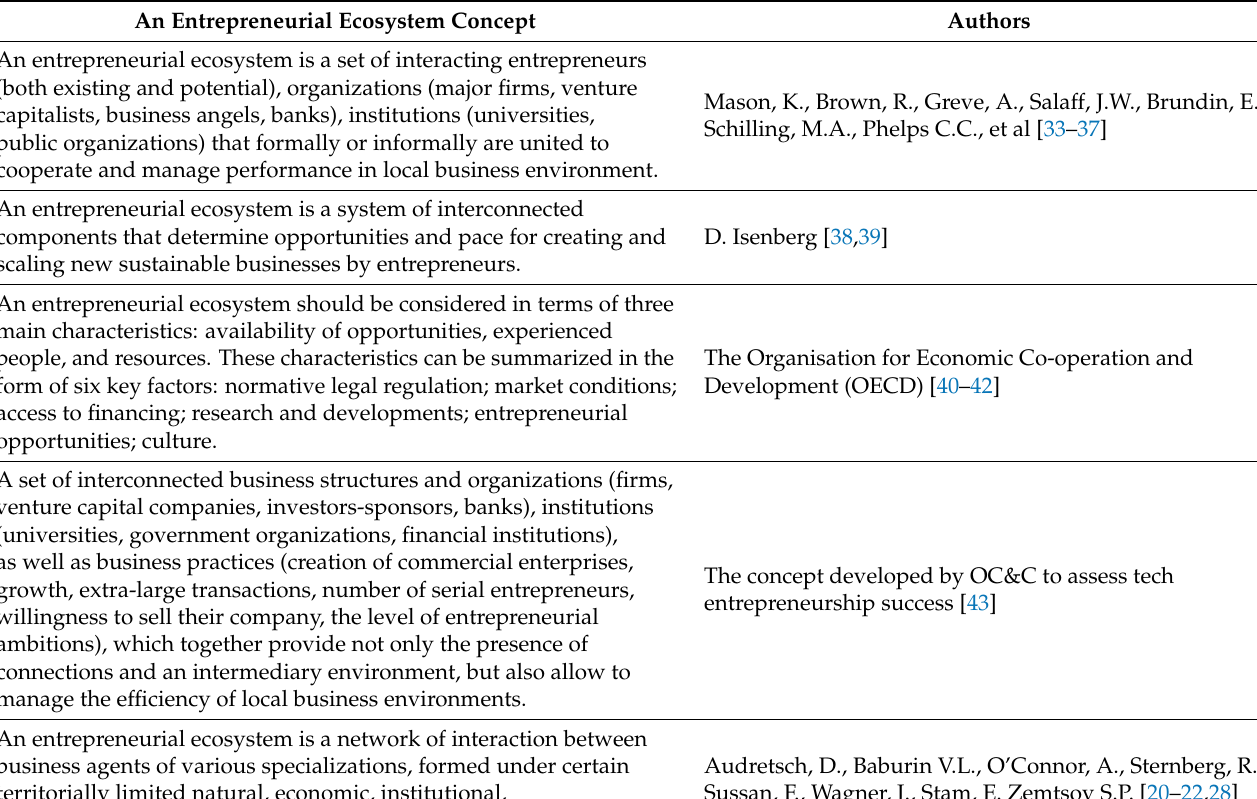
Table 1. Content analysis of entrepreneurial ecosystem